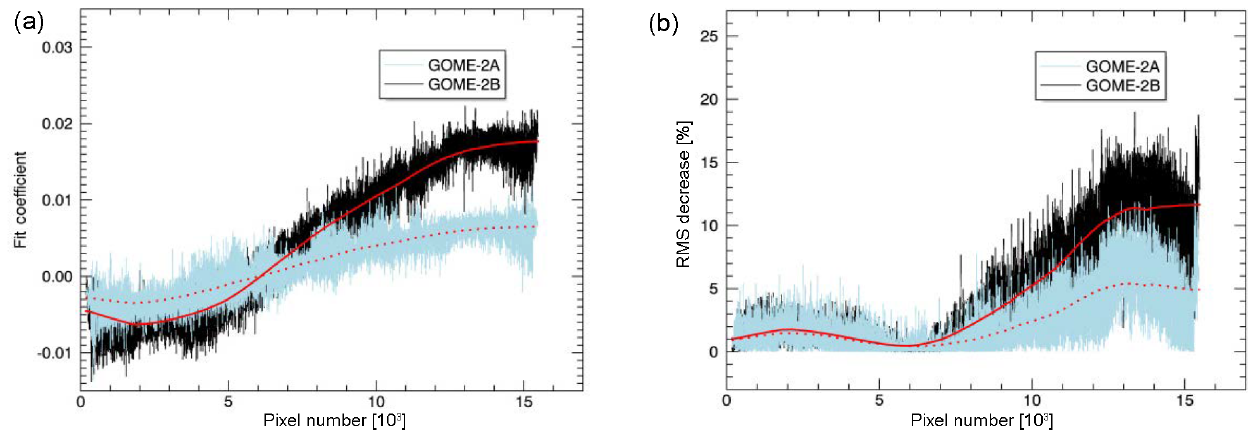
Figure 3. Changes of GOME-2 slit function width along orbit 32636 on 1 February 2013 (a) and the impact on the retrieval rms error (b) . Red lines provide the boxcar average for GOME-2A (dotted) and GOME-2B (solid). A fit coefficient of 1 × 10 − 2 corresponds to a change in the slit function width of ∼ 2 . 8 × 10 − 3 nm (a) .